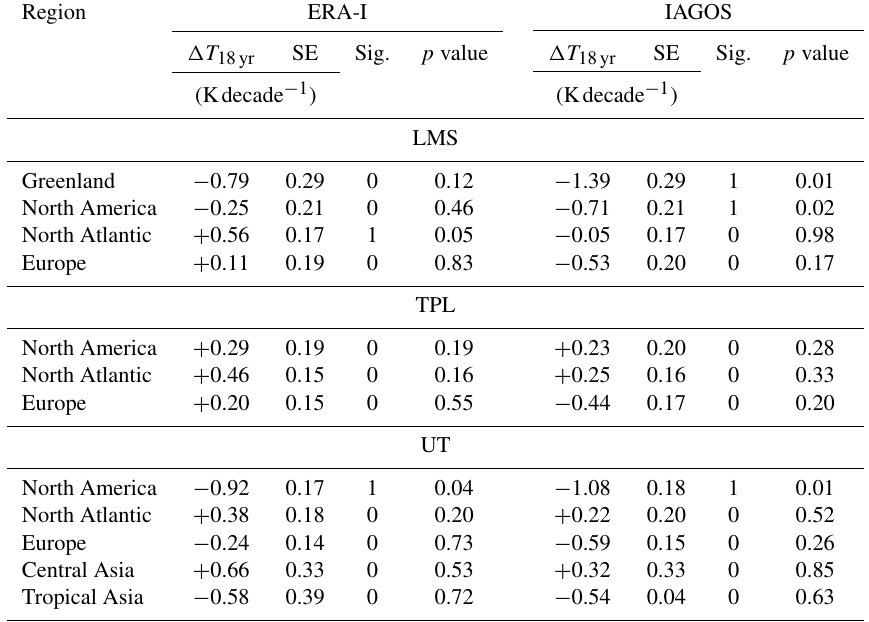
Table 3. Temperature trends in ERA-I and from the IAGOS observations within the LMS, TPL, and UT, for which at least 90% of mea- surements were available over the entire period (1995–2012). SE is the standard error of the temperature trend. The temperature trend is significant (Sig = 1) if the p value (consistency) is smaller than 0.06 ( > 94%), which was derived from the Mann–Kendall